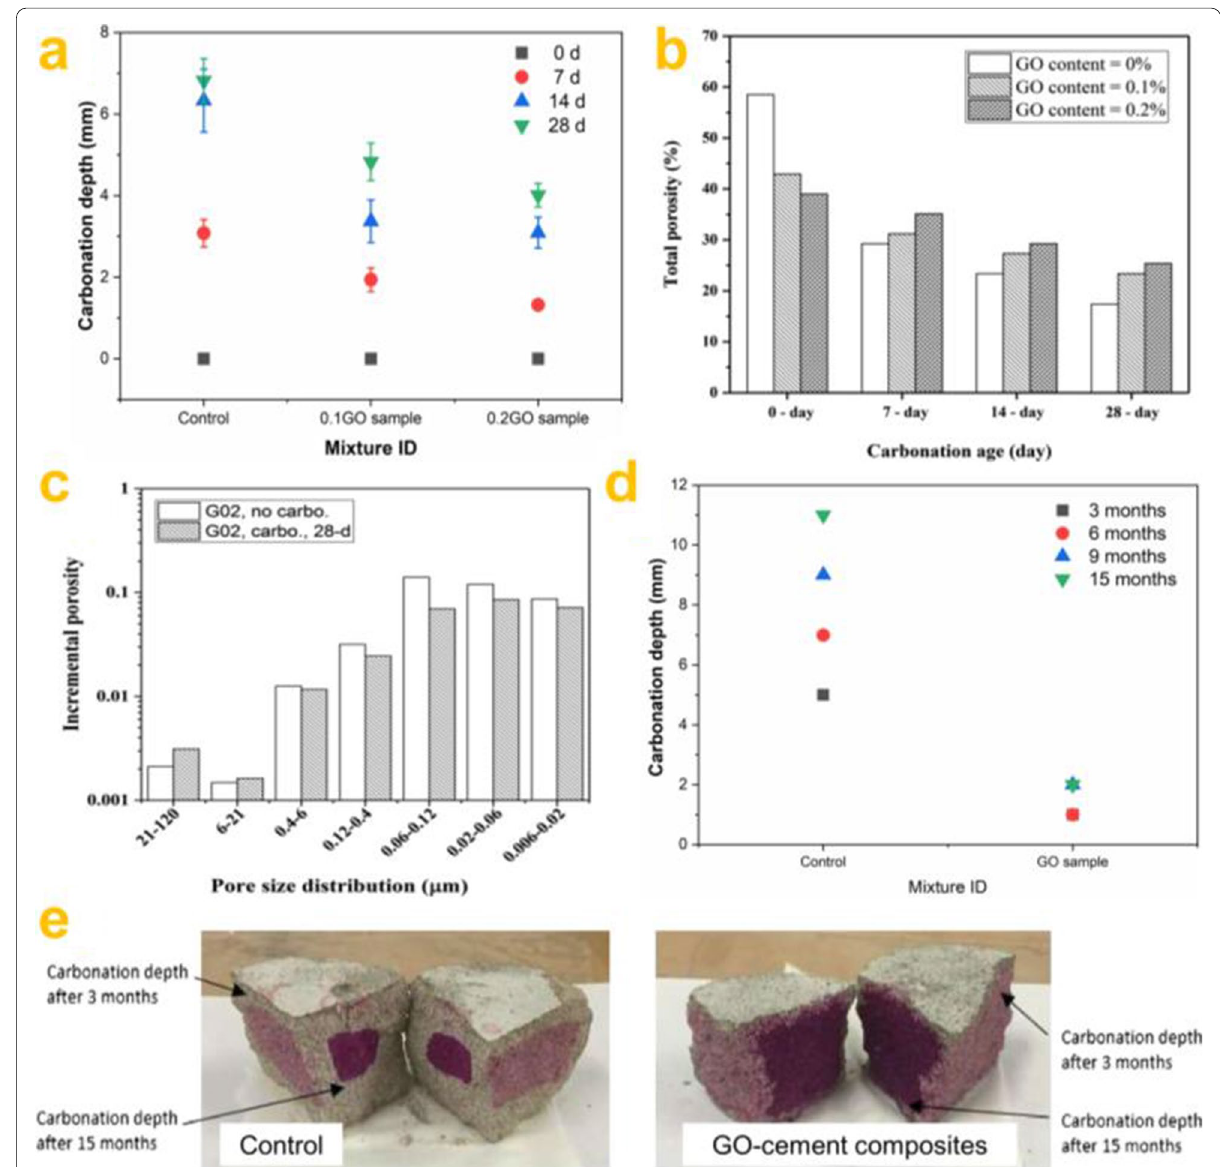
Fig. 10 a Carbonation depth of GO-cement composites, b porosity and pore structure, c changes of cement composites with different GO contents [53]. (Copyright 2018 Elsevier). d Carbonation depth of cement composites with 0.06 wt% GO, and e images of cement pastes after carbonation [155]. (Copyright 2018 Elsevier). Note: Carbo is carbonation and the GO content is by weight of